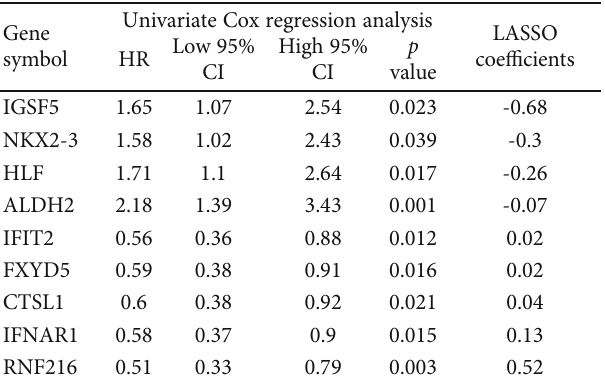
Table 1: 9-gene immune signature. Univariate Cox regression analysis